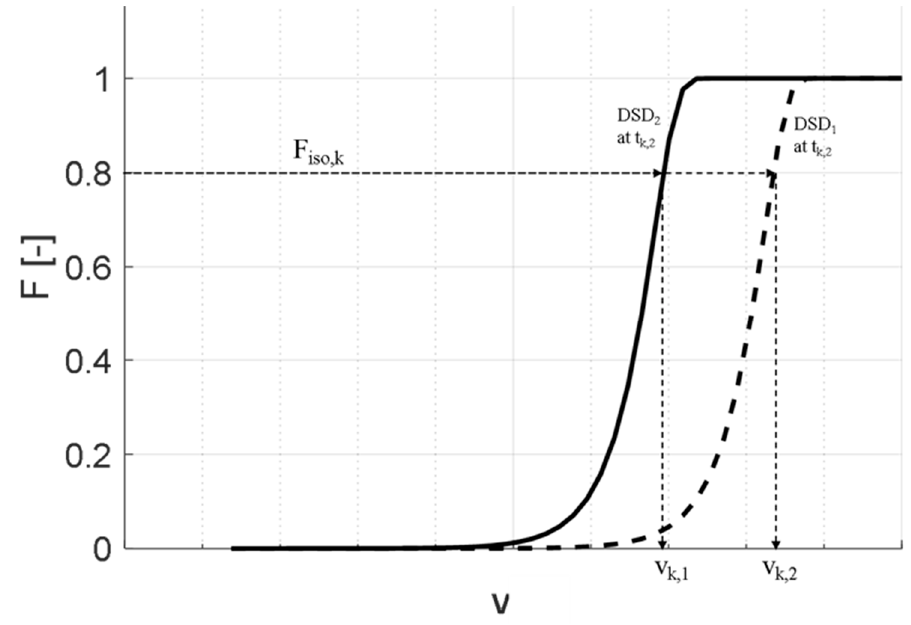
Figure 8. Illustration of how vector pairs ( v k , t k ) are formed from the cumulative DSDs for inverse self-similarity analysis.